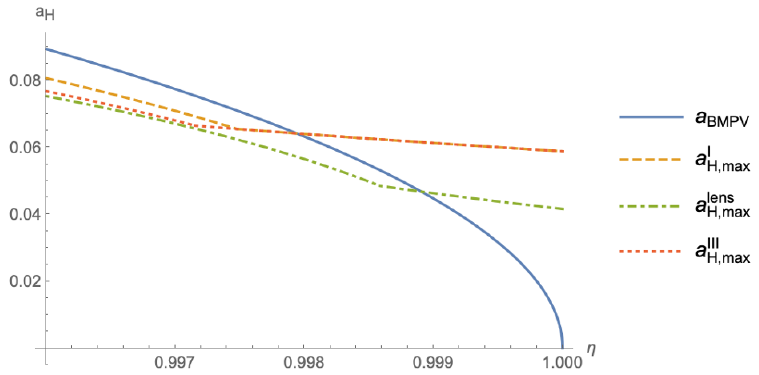
Figure 9. Maximum horizon areas of the di(cid:11)erent solutions near (cid:17) = 1. Spherical black holes I and III have maximum areas exceeding those of the other solutions for (cid:17) > 0 : 997940.